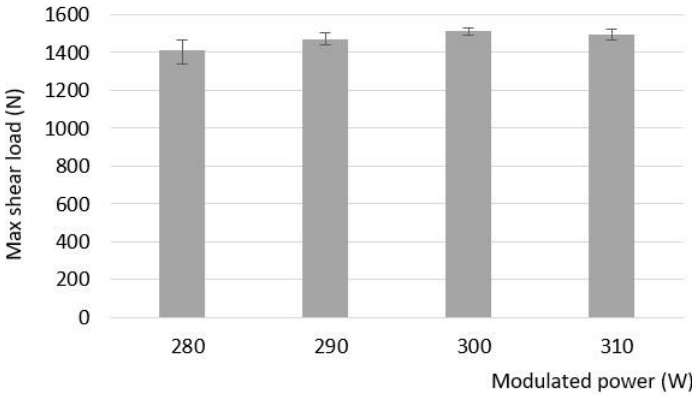
Figure 15. The result of tensile-shear tests measuring the maximum force in the function of the modulated power. Table 6. Different failure modes of the PP-Al joint.